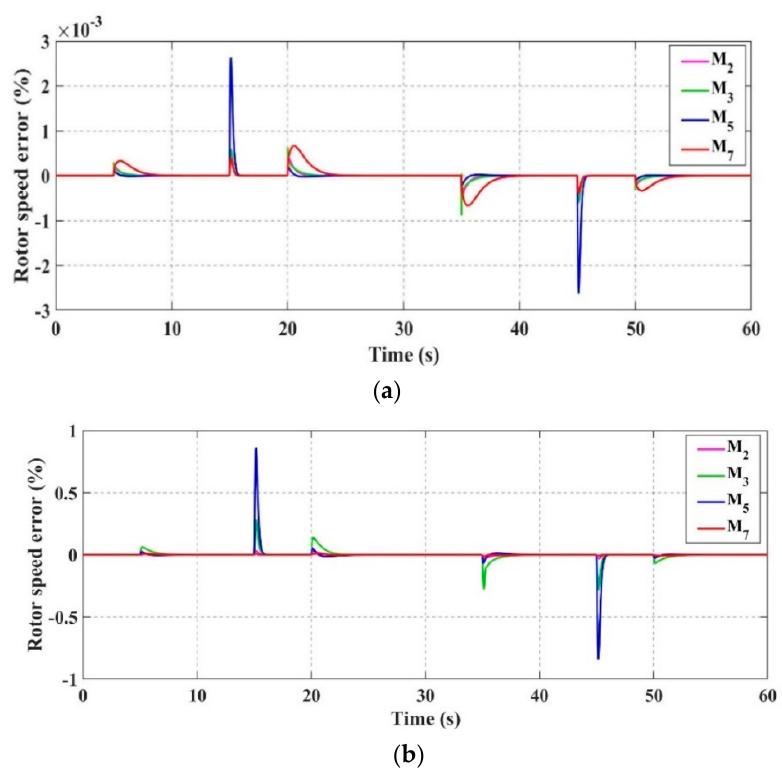
Figure 11. Rotor speed errors in percentage (%). ( a ) Vector control; ( b ) simplified control. Table 2. Comparison of average rotor speed error (%).